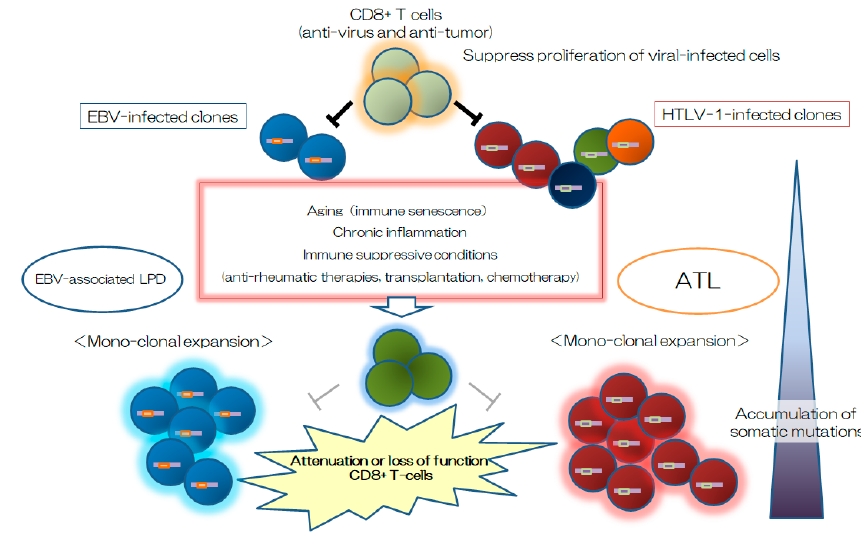
Figure 2. Involvement of host immunity status in the pathogenesis of viral-associated lymphoproliferative disorder (LPD). It is unclear whether there any underlying common causes between Epstein–Barr virus (EBV)-associated LPD and adult T-cell leukemia (ATL). Host immunity has an important role in suppressing expansion of viral-infected cells in a host. Immunosuppressive treatment, including not only antirheumatic therapies, but also organ transplantation, attenuates the anti-viral immunity of the host. Furthermore, aging, immune senescence, and inflammation may also cause remodeling of the immune system, such as innate immunity and acquired immunity. Indeed, it is well known that the incidence of EBV-associated LPD was increased by methotrexate during antirheumatic therapy. On the other hand, accumulation of somatic mutations is involved in the clonal expansion of ATL cells because ATL cells that accumulate somatic mutations can escape from the anti-viral and anti-tumor immune systems. Although HTLV-1-positive patients with rheumatic diseases may be categorized as having a high risk for developing ATL, it remains unclear whether antirheumatic therapies and chronic inflammation increase the incidence of ATL.